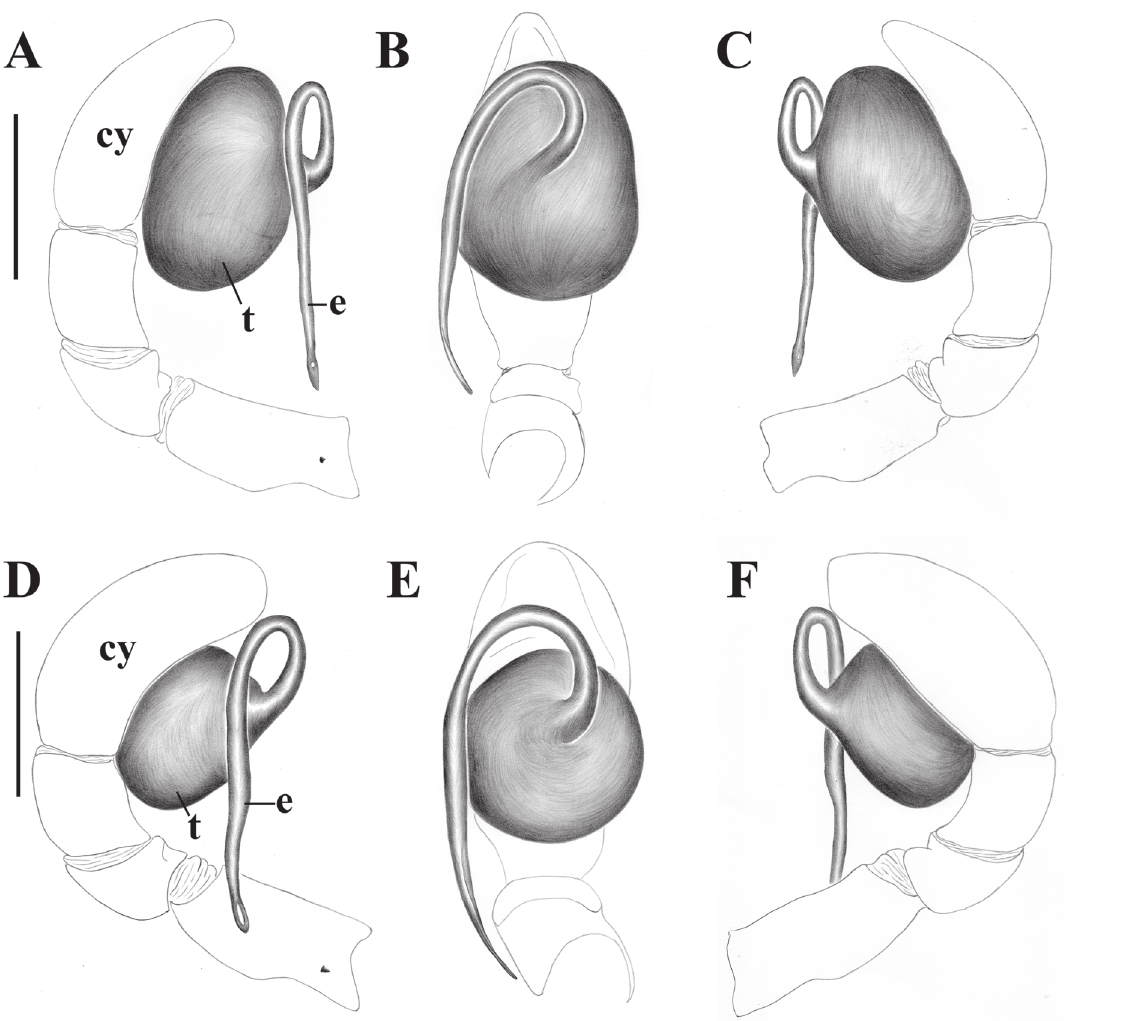
Fig. 4. A – C . Caponina bochalema sp. nov., ♂, holotype (IAvH-I 3757). A . Left palp, retrolateral view. B . Left palp, ventral view. C . Left palp, prolateral view. – D – F . Caponina huila sp. nov., ♂, holotype (IAvH-I 3761). D . Left palp, retrolateral view. E . Left palp, ventral view. F . Left palp, prolateral view. Scale bars = 1 mm. Abbreviations: see Material and